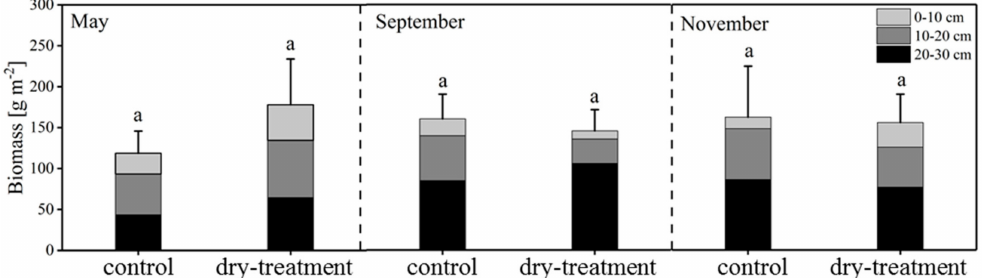
Figure 4. Development of fine root biomass from both the control and dry-treatment groups in May, September and November. Data are means of four soil cores for each individual tree for three vertical layers: 0–10, 10–20 and 20–30 cm. The letters indicate no significant di ff erences ( p > 0.05) between the control and dry-treatment groups for the total fine root